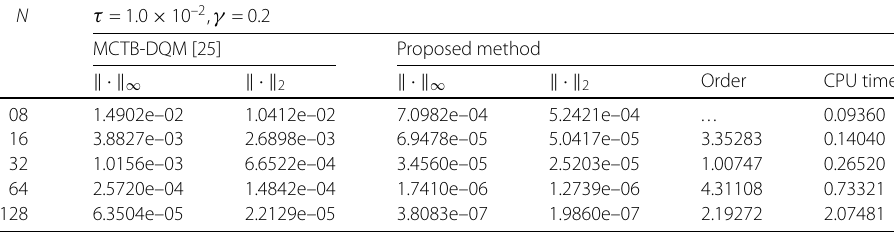
Table 1 A comparison of maximum error ( (cid:10) · (cid:10) ∞ ) and Euclidean norm ( (cid:10) · (cid:10) 2 ) at T = 1 for problem-1 N